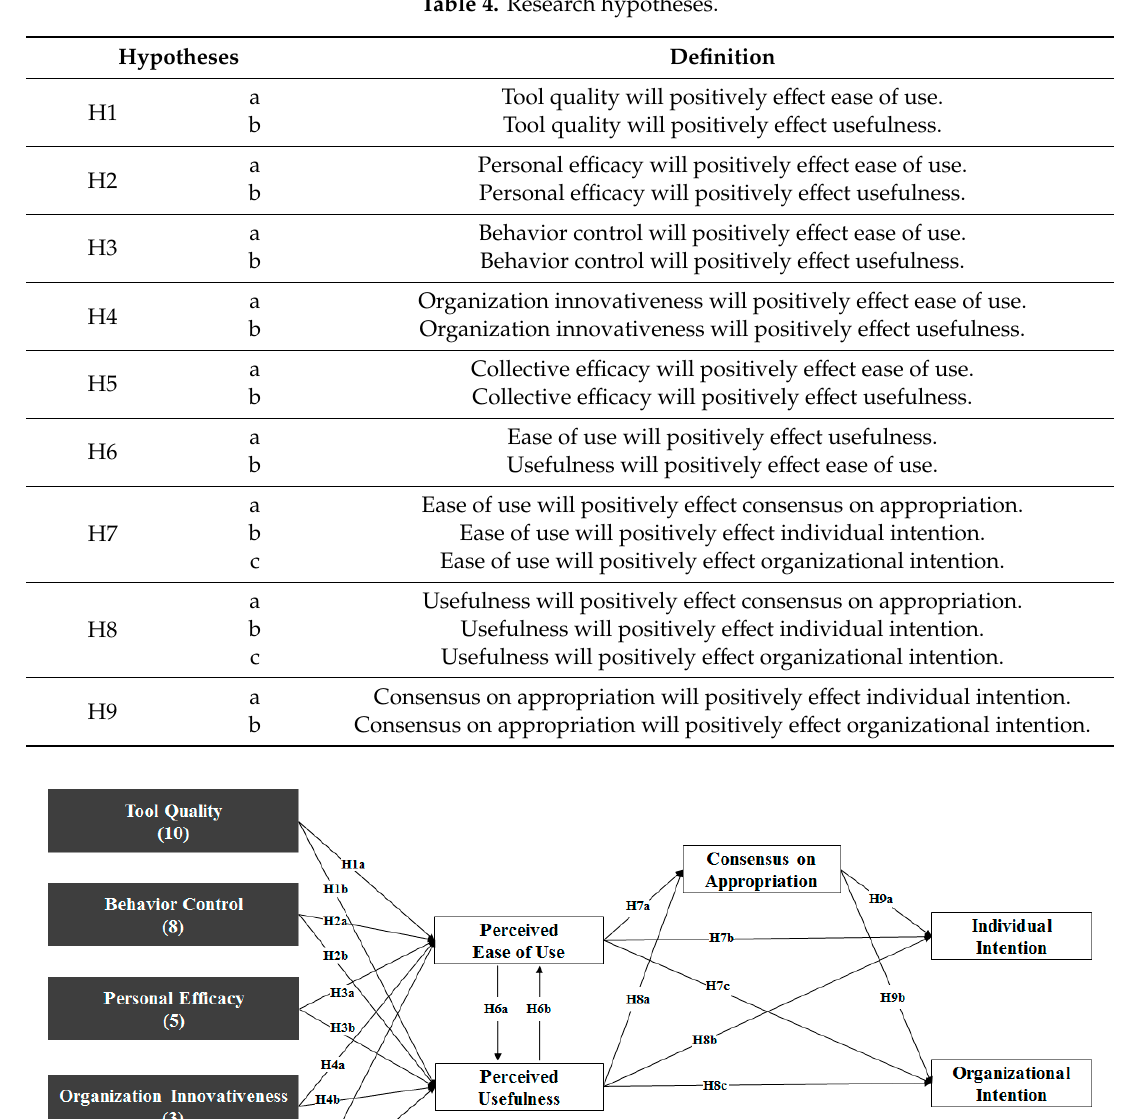
Table 4. Research hypotheses.